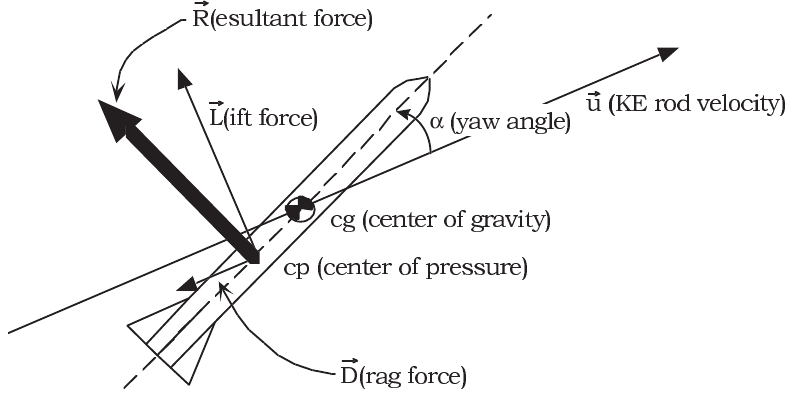
Fig. 9. Illustrating the lift and drag force directions, as well as the CG and CP